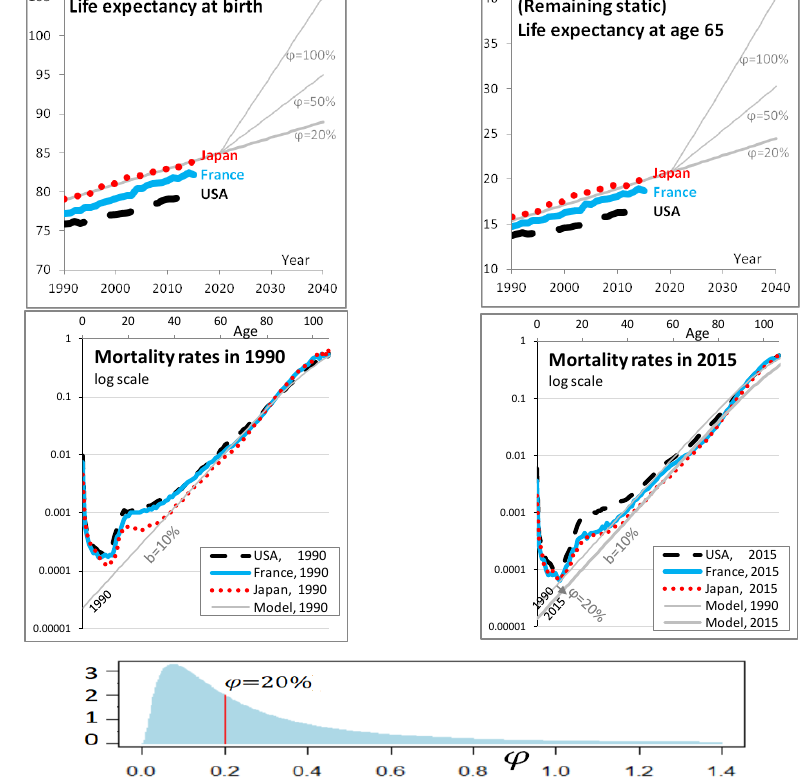
Figure 1. Characteristics of the chosen longevity model. In the first two graphs, remaining life expectancy at respectively birth and age 65 is computed from year 1990 to 2040 based on the model (see Equation (1)), in gray lines using different values of φ as written, and from 1990 to 2015 for specific countries based on historical data (more precisely based on the mortality rates estimates provided by the Human Mortality Database): Japan in (red) short dashes, France in (blue) continuous lines, and the USA in black long dashes. As expected, life expectancies are greater in Japan than in France and lower in the USA. The model fits life expectancy and mortality rates of Japan. The same style of lines is used for the next two graphs, that represent the mortality rate at different ages in log scale, for the years 1990 and 2015, respectively. The model matches the Japanese mortality well from age 40 to 85; mortality rates at these ages are important to model life expectancy at age 65 and below (see Debonneuil et al. 2017). In the fourth graph, the model at 1990 is additionally shown to provide a visual reference on how mortality rates have evolved from 1990 to 2015. The fifth graph shows the chosen lognormal probability density of φ . 2.3. Implication for a Pension Fund in Terms of Needed Prudential Capital Let us use a simple model of a pension fund to apply the longevity model and compute capital needs. Population studied. We consider the following cohort defined as such at time t = 0: 300 employees of age 20, 300 ∙ (1 − q 20,0 ) employees of age 21, 300 ∙ (1 − q 20,0 )(1 − q 21,0 ) employees of age 22, etc. until an age 64 and no retired persons. This provides a distribution of the population across ages that is roughly natural. When applying the mortality model, this corresponds to 13,000 people at time t = 0 (year 2020). We follow this closed portfolio over time (t = 1, 2, etc.) and every year people die according to mortality rates. For the sake of simplicity, we do not model arrivals nor departures. The number of people aged x at time t is then: N x,t = (300 ∏ (1 − v<𝑥−𝑡 v≥20 q v,0 )) ∏ (1 − v<x v≥x−t q v,t+v−x )